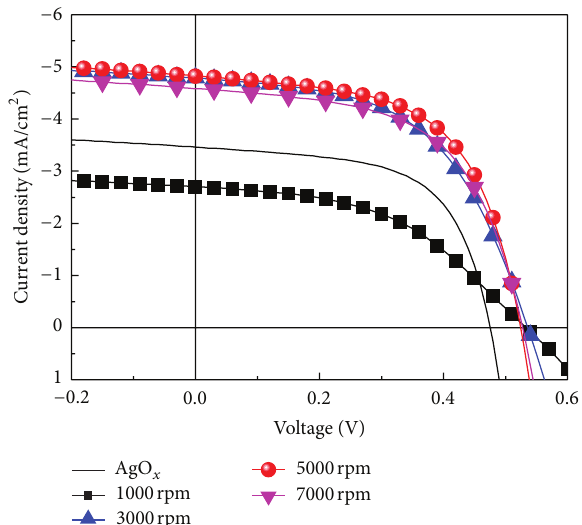
Figure 6: 𝐽 - 𝑉 characteristics of TOPVs under AM1.5 solar simula- tor